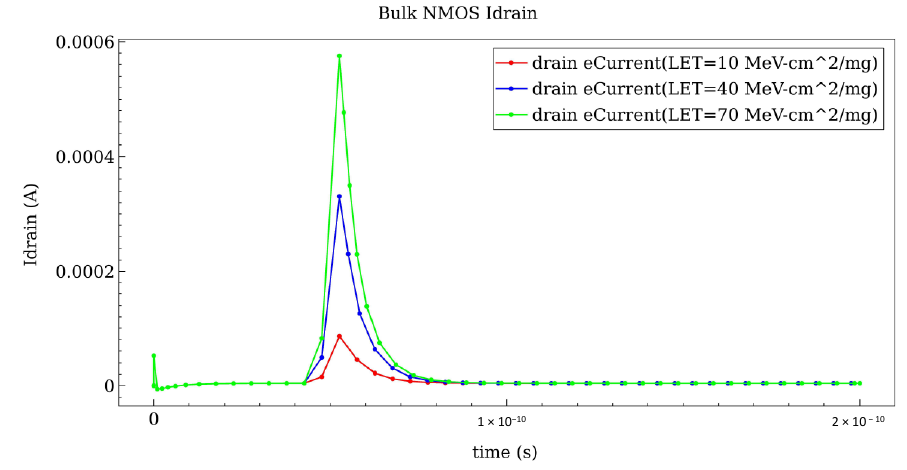
Figure 2. Drain current of NMOS for different LET values of the heavy